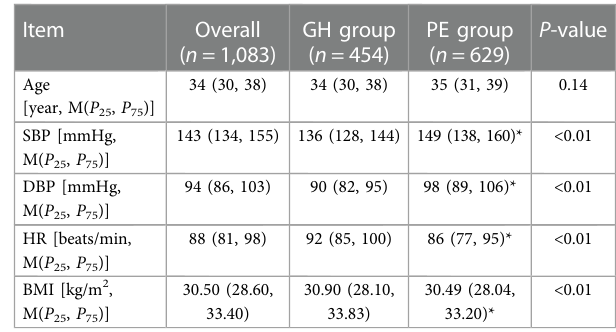
TABLE 1 Comparison of baseline indicators between GH group and PE